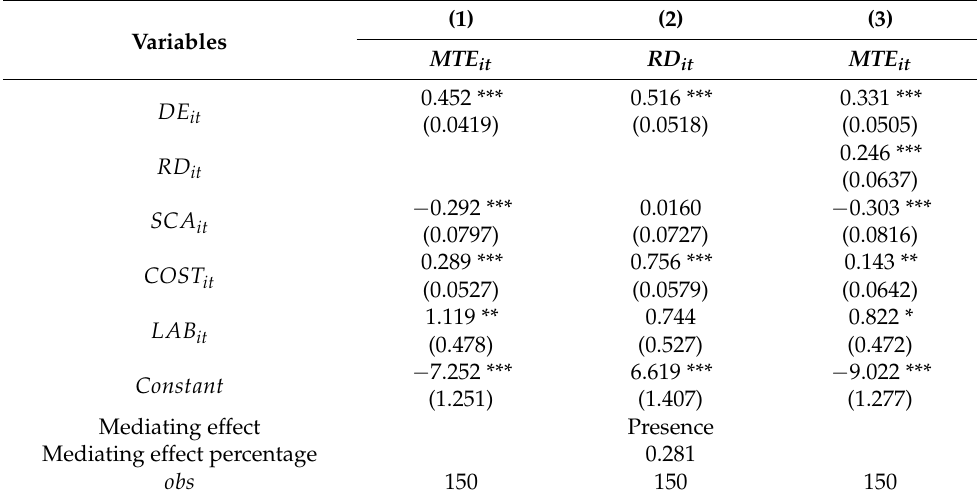
Table 8. Mediation effect test